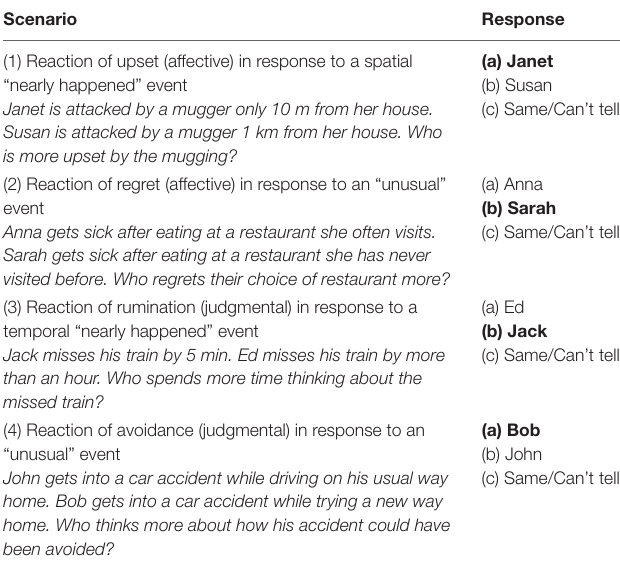
TABLE 1 | The Counterfactual Inference Test (Hooker et al.,